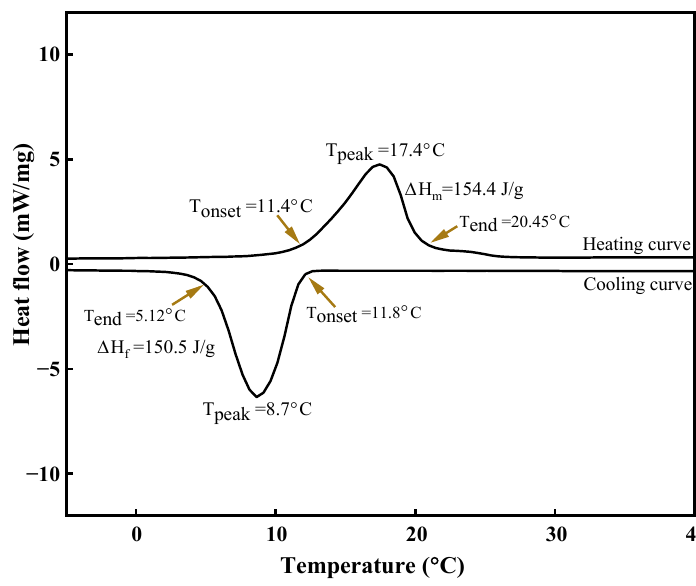
Figure 6. DSC curve of the caprylic acid-stearyl alcohol (CA-SA). The thermal conductivity is a significant property of PCM for enhancing the performance of the heat transfer during phase transition. The thermal conductivity of the prepared binary mixture was measured in the solid and liquid phases and it is shown in Figure 7. The organic liquids have a lower thermal conductivity in the range of 0.1–0.2 W/m.K [33]. The measured thermal conductivity in the solid phase was 0.242 and 0.267 W/m.K at − 5 ◦ C and 0 ◦ C, whereas in the liquid phase it was 0.165, 0.160, and 0.157 W/m.K at 20 ◦ C, 25 ◦ C, and 30 ◦ C, respectively. The thermal conductivity for each temperature was measured three times and the average value was marked with uncertainty in solid phase ((SH-1) ± 10%) and liquid phase ((KS-1) ± 5%). The thermal conductivity in the solid phase was more pronounced due to the tightly packed molecules [34]. The measured thermal conductivity for the pure caprylic acid was approximately 0.15 W/m.K, whereas for stearyl alcohol it was 0.248 W/m.K [35,36]. Therefore, the thermal conductivity of the prepared eutectic mixture is in good agreement with pure materials reported in the literature, which will enhance its performance for the cooling application.